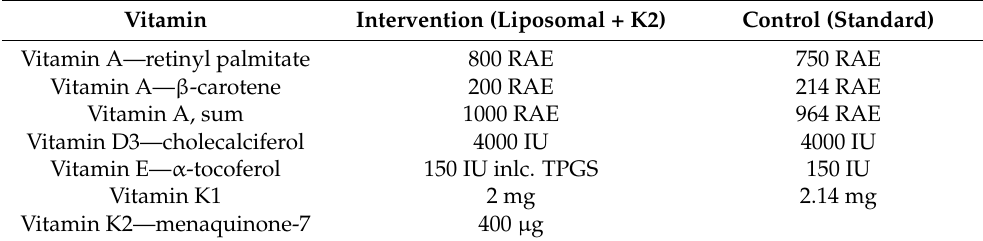
Table 1. Mean daily doses of fat-soluble vitamins in the intervention and the control group. The dose of vitamin A was 3.7% larger in the intervention group. The vitamin K1 dose was 7% larger in the control group.